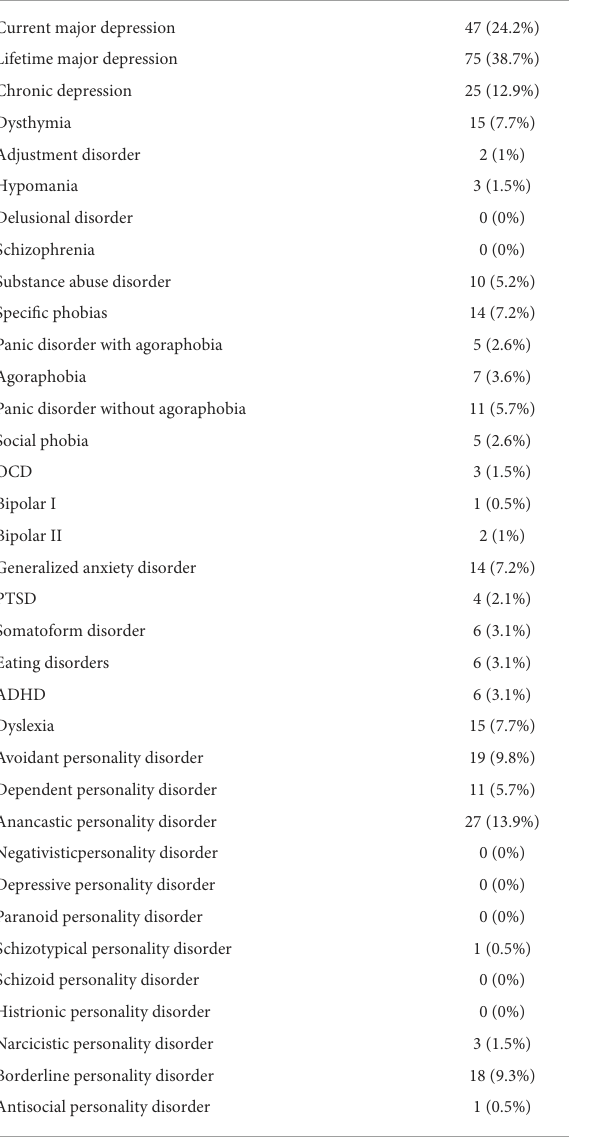
TABLE 2 Complete results from SCID-Diagnostics as n (% of N ). TABLE 3 Data relevant for the